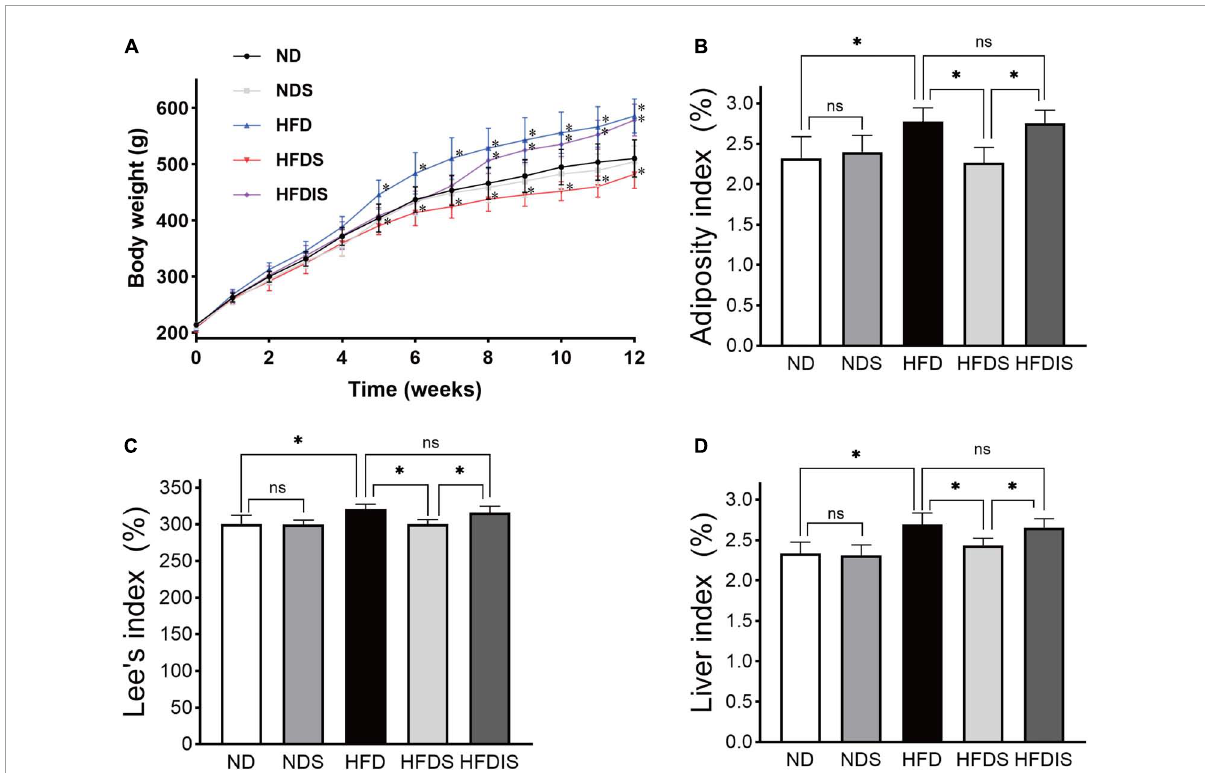
FIGURE1 Effect of Miao sour soup (MSS) on the Body Weight and Fat Deposition of high-fat diet (HFD)-fed rats. (A) Body weights of rats during the 12 weeks. (B) Adiposity index of rats. (C) Lee’s index of rats. (D) Liver index of rats. ND: normal diet + distilled water (12 weeks); NDS: normal diet + MSS (12 weeks); HFD: high-fat diet + distilled water (12 weeks); HFDS: high-fat diet + MSS (12 weeks); HFDIS: high-fat diet + MSS (the first 6 weeks) and then distilled water (the last 6 weeks). * p < 0.05 indicates significant difference, ns indicates no significant difference (ND vs. NDS, HFD; HFD vs. HFDS, HFDIS; HFDS vs.